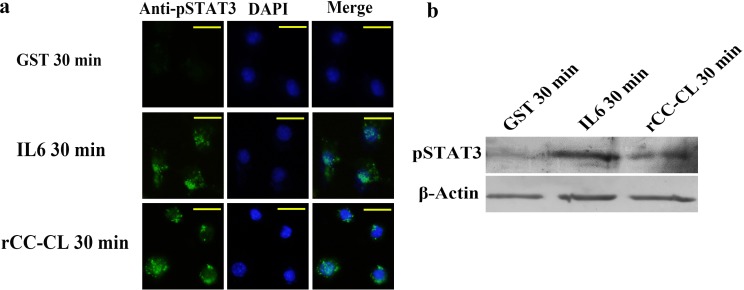
MjCC-CL induces STAT3 phosphorylation in mouse macrophages.(A). STAT3 phosphorylation in GST, IL6 or rMjCC-CL-treatment macrophages at 30 min was detected using an immunocytochemical assay with pSTAT3 antibody. (B). STAT3 phosphorylation in GST, IL6 or rMjCC-CL-treatment macrophages at 30 min was detected by western blotting. GST and IL6 were separately used as positive and negative control. Scale bars represented 20 μm.